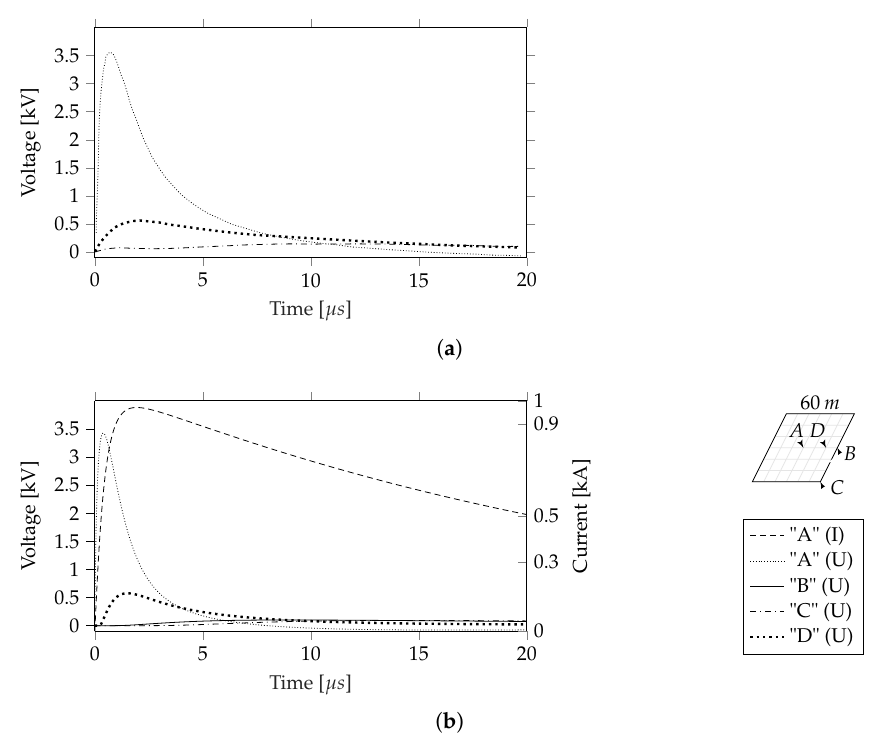
Figure 4. Voltage distribution in a grounding grid consisting of 6 × 6 meshes of 10 m size. The grounding grid consist of copper conductors of AWG 2/0, buried at d = 0.6 m in soil of ρ soil = 100 Ω m and (cid:101) r soil = 36: ( a ) the reproduced results for comparison from research given in [7] (p. 31); and ( b ) results from implemented model with excitation current ˆ I = 1 kA of double exponential waveform ( α = 38 × 10 3 , β = 2.54 × 10 6